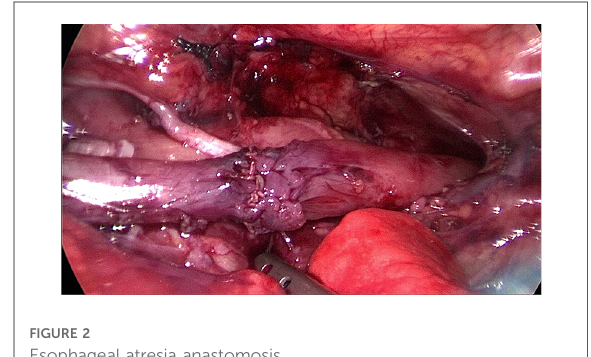
FIGURE 2 Esophageal atresia